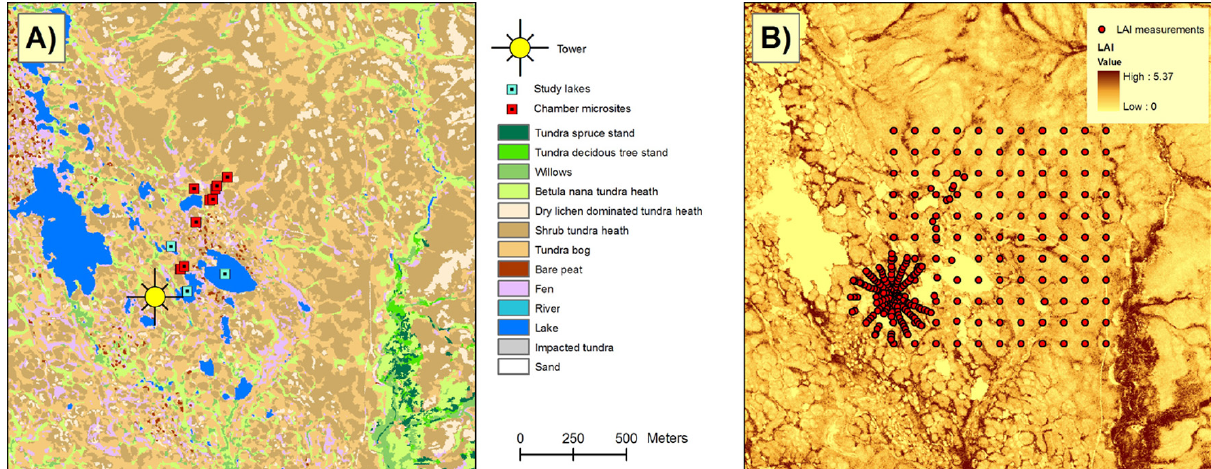
Fig. 1. (A) Land cover classification of the study area. Location of the eddy covariance mast, chamber microsites and thermokarst lakes studied are shown on the map. (B) LAI map, showing the location of the LAI ground